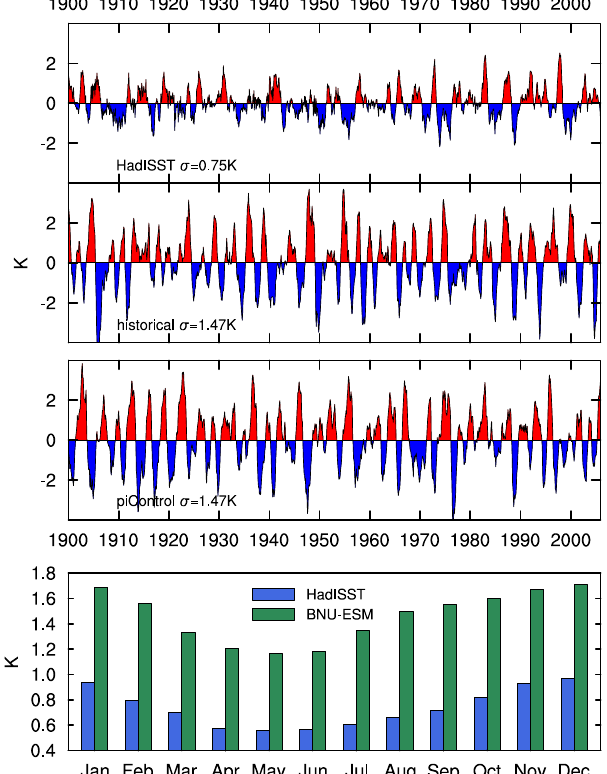
Figure 17. Time series of detrended monthly SST anomalies of the Niño-3.4 region (5 ◦ S–5 ◦ N, 170–120 ◦ W) from HadISST, the BNU-ESM historical and piControl runs. The anomalies are found by subtracting the monthly means for the whole time series. The bottom sub-figure is standard deviation of monthly Niño-3.4 SST anomalies from HadISST and the BNU-ESM historical